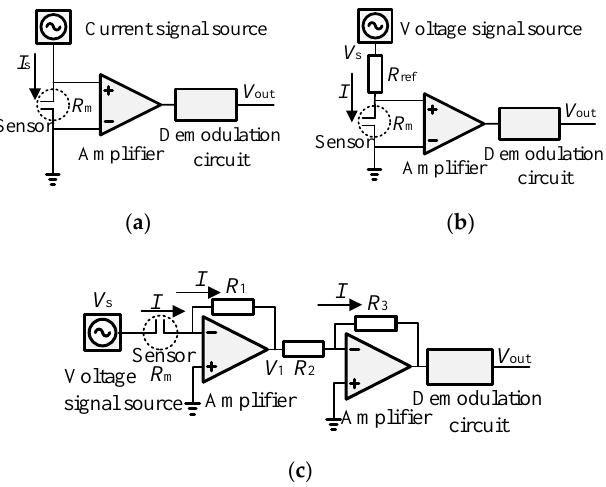
Figure 1. The circuits of three typical conductivity detection methods: ( a ) Method one; ( b ) Method two; ( c ) Method three.